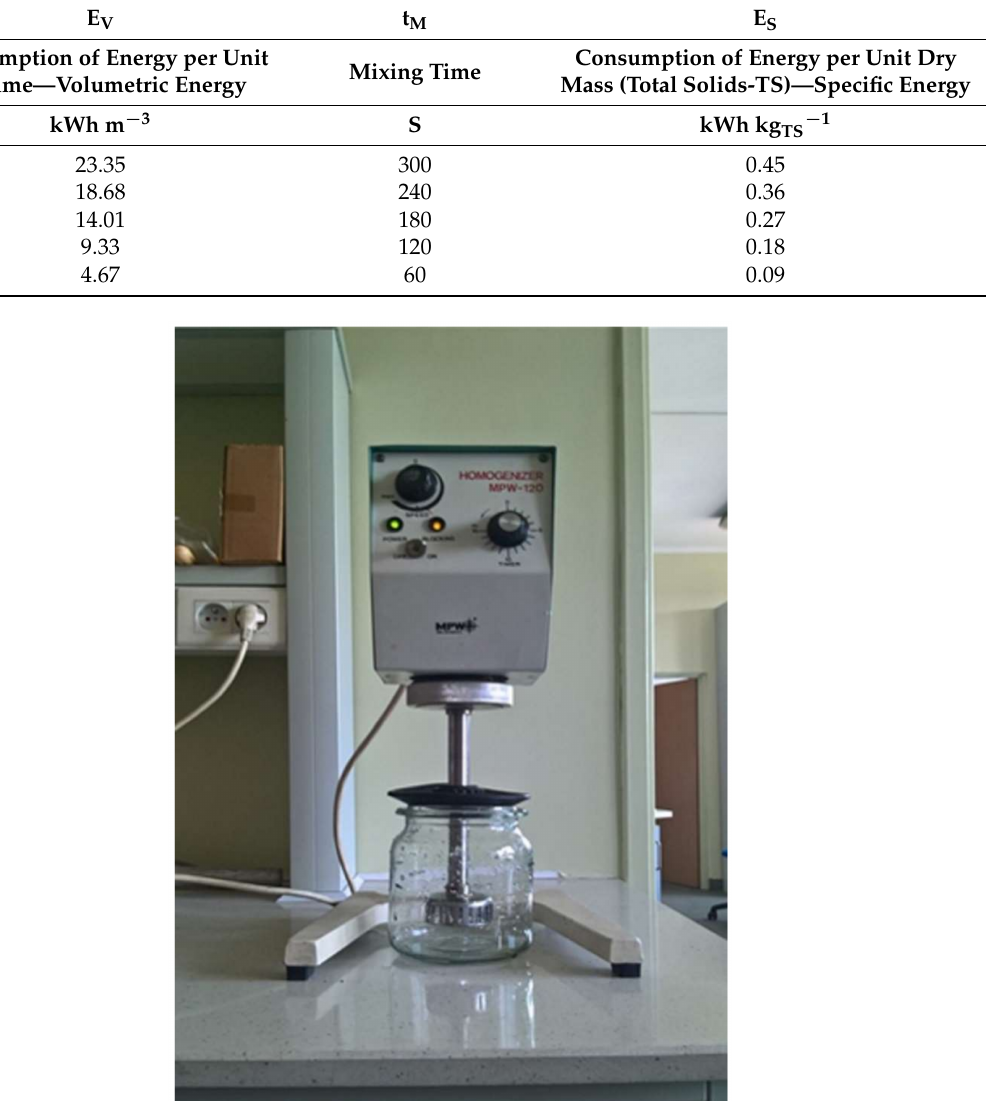
Table 2. Parameters of the mechanical disintegration—Laboratory scale homogenizing mixer.